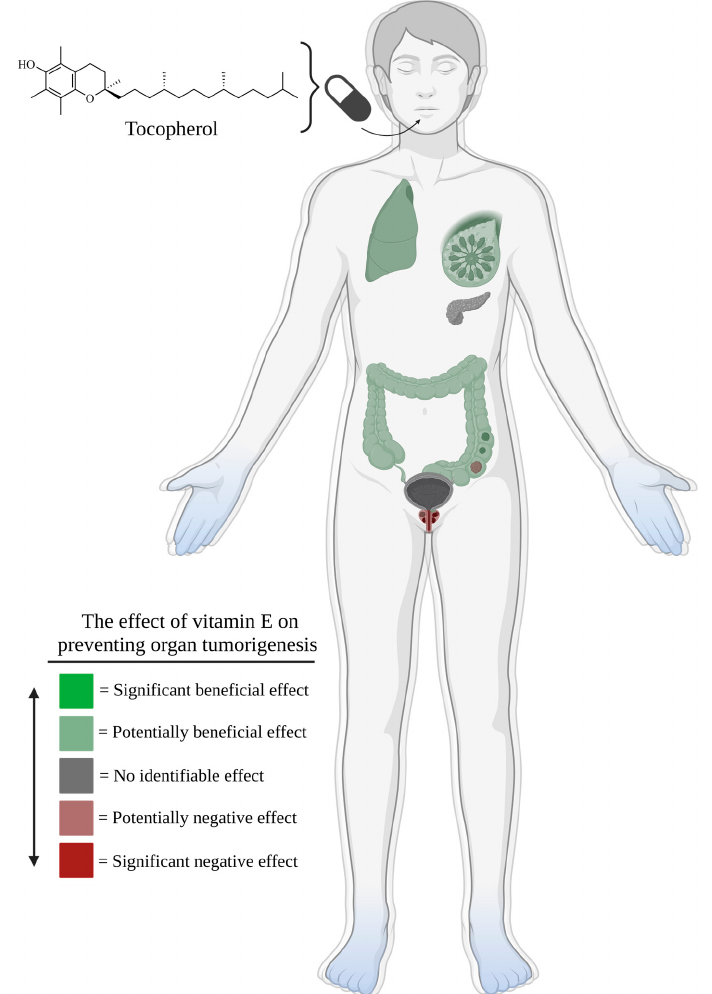
Figure 5. As seen in the figure scale, regions highlighted in bright green would be indicative of consistent and significant evidence supporting an inverse relationship between vitamin E supplementation and cancer risk, but no such systems exist. Pale green regions represent systems in which there is mixed evidence supporting an inverse relationship between vitamin E supplementation and cancer risk, as well as evidence supporting no relationship between vitamin E supplementation and cancer risk. Pale green regions indicate these findings for breast, lung, and colorectal tissue. Grey regions signify consistent evidence supporting no relationship between vitamin E supplementation and cancer risk. Grey regions indicate these findings for pancreatic and bladder tissue. Pale red regions represent systems in which there is mixed evidence supporting a relationship between vitamin E supplementation and increased cancer risk, as well as evidence supporting no relationship between vitamin E supplementation and cancer risk. The pale red region indicates these findings for prostatic tissue. Lastly, regions highlighted in bright red would be indicative of consistent and significant evidence supporting a relationship between vitamin E supplementation and increased cancer risk; however, no such systems exist.